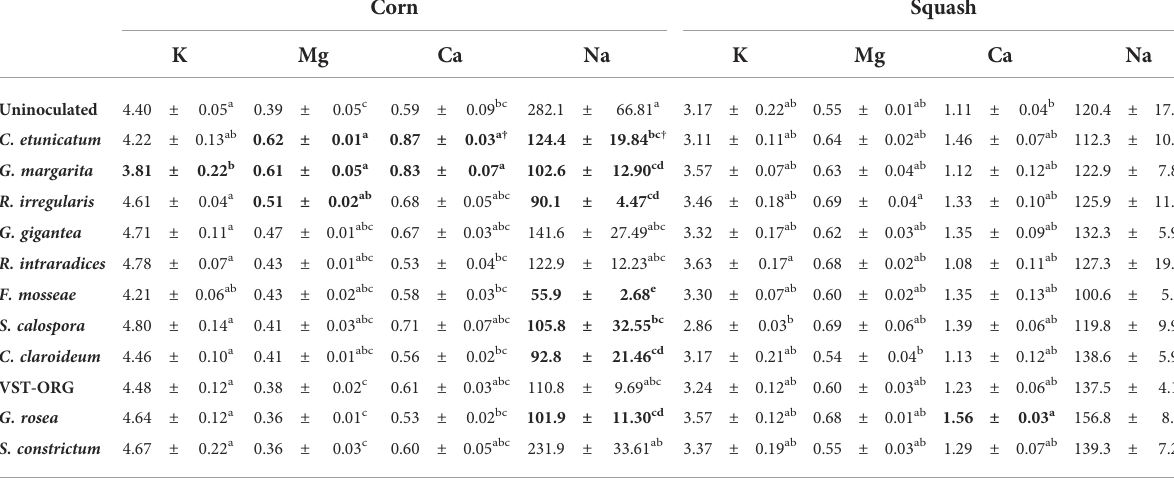
TABLE 2 Potassium (K), magnesium (Mg), calcium (Ca), and sodium (Na) concentration (ppm) in corn and squash seedlings inoculated with mycorrhizae. Corn